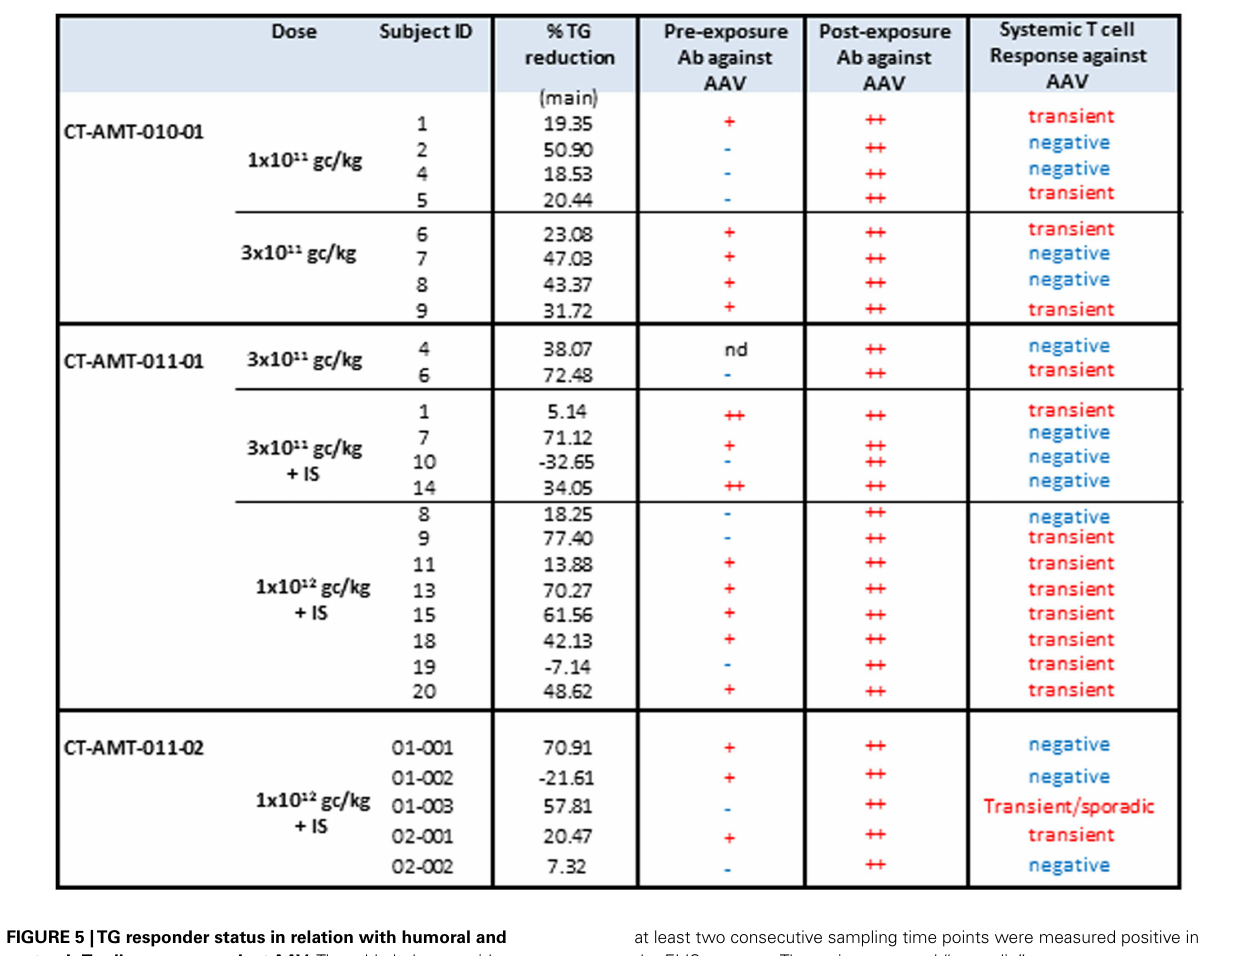
FIGURE 5 |TG responder status in relation with humoral and systemicT-cell response againstAAV .The table below provides an overview of the individual patient cellular and humoral immune responses in relation with the clinical end point (fasting) total plasmaTG. AT-cell response to the antigen was reported transient positive (transient) when